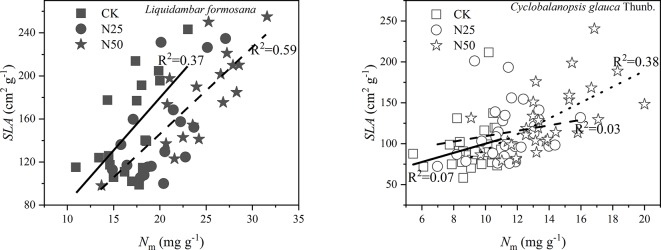
The specific leaf area (SLA) as samples of ten leaves averaged for each individual of Cyclobalanopsis glauca Thunb. and Liquidambar formosana selected for gas exchange measurements as a function of leaf N per unit mass (N
m). Solid lines fit linearly to the CK data, broken lines fit linearly to the N25 data, and dotted line fit linearly to the N50 data. Of note, the data of N25 and N50 share the same relations for L. formosana.